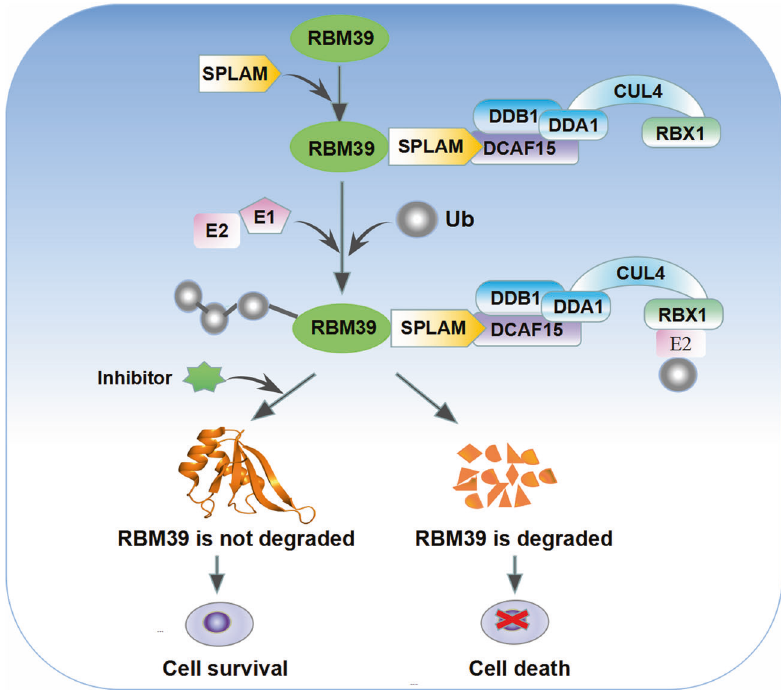
Fig. 4 Schematic diagram of SPLAMs promoting degradation of RBM39. SPLAMs promote the interaction between RBM39 and DCAF15 E3 ligase substrate receptor, leading to ubiquitination of RBM39 and proteasome-mediated degradation, while proteasome inhibitors can prevent RBM39